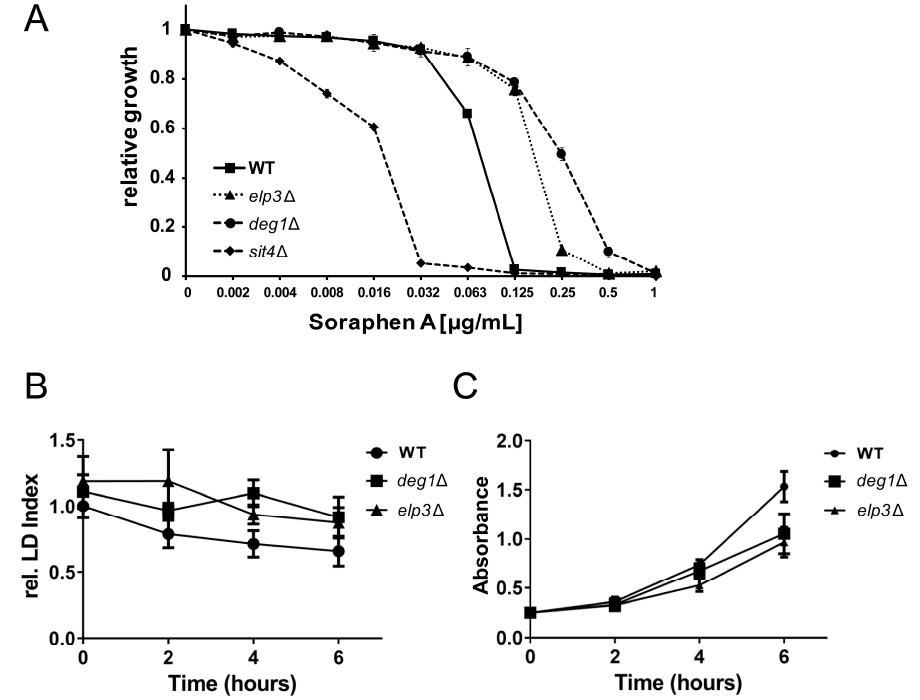
Figure 4. Soraphen A resistance and lipolysis defect in deg1 mutants. ( A ) Microtiter based measurement of growth inhibition of indicated strains by soraphen A. Relative growth refers to optical density (O.D 600 nm) of microcultures with indicated concentrations of soraphen A as compared to soraphen A free cultures. Measurements were carried out in triplicate and shown as mean plus standard deviation. ( B ) Lipid droplet dynamics and ( C ) growth of BY4741 (WT) and its isogenic elp3 and deg1 mutants was determined during exponential phase of growth (6 h). The mean ± S.D. of three independent experiments is shown.